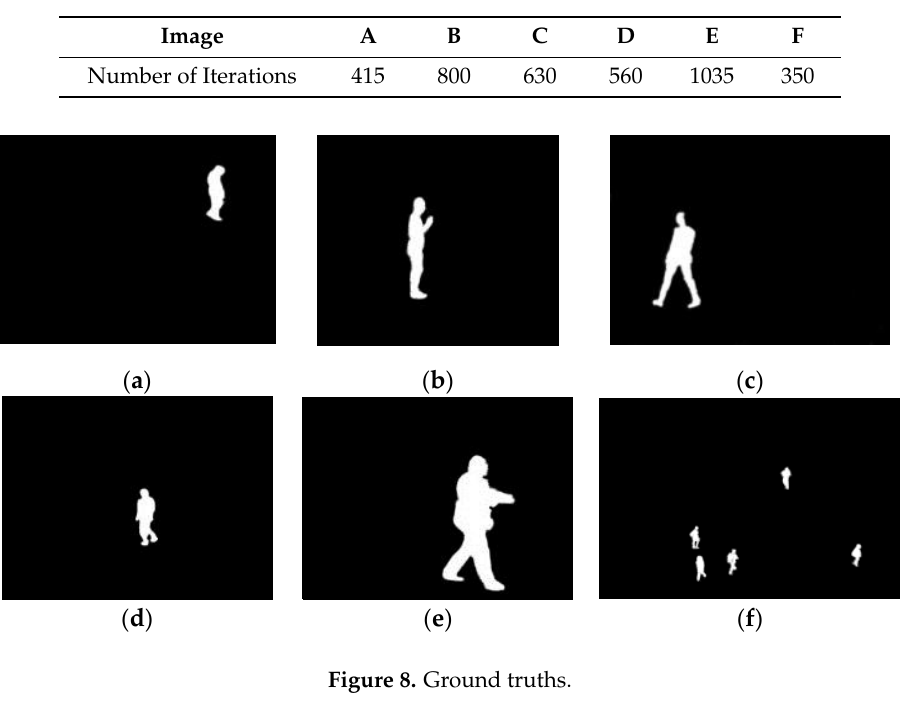
Table 2. Number of iterations of the proposed method.